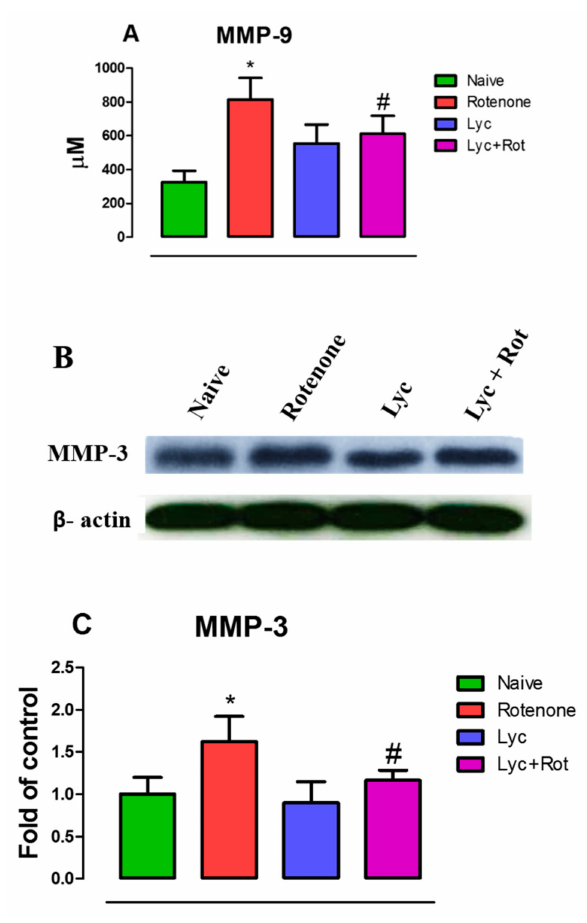
Figure 4. Treatment with Lyc diminished the expression of MMP-9 and MMP-3. Rotenone-treated animals showed a significant increase in matrix metalloproteinases, MMP-9 ( A ) and MMP-3 ( B ). However, treatment with Lyc diminished the expression of MMP-9 and MMP-3 by virtue of its anti-inflammatory action. Histogram ( C ) represents densitometric analysis of western blots, and values are expressed as mean ± SEM. * p < 0.05 compared to control, # p < 0.05 compared to the rotenone-treated